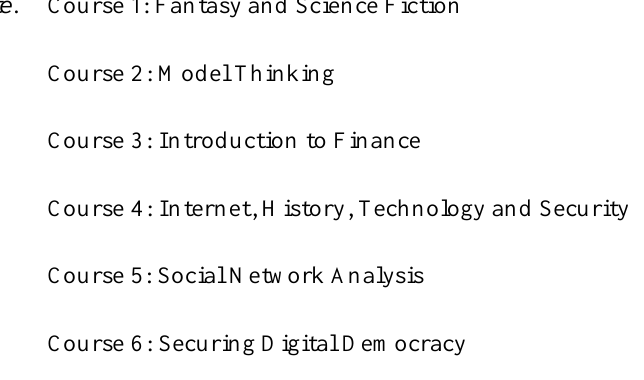
Figure 2 . Percentage of course enrollment by degree